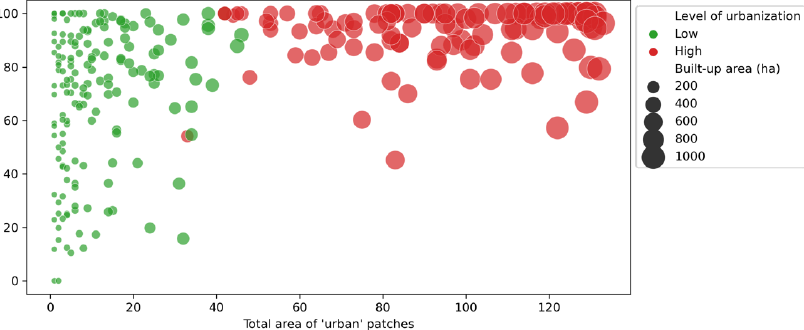
Figure 6. Relationship between the size of the urbanised area ( x -axis) and access to basic water facilities ( y -axis), by level of urbanisation (urban subset shown in red). Elaborated by the authors.